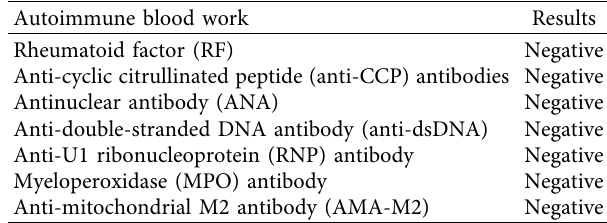
Table 1: Autoimmune work up conducted during hospital course. Autoimmune blood